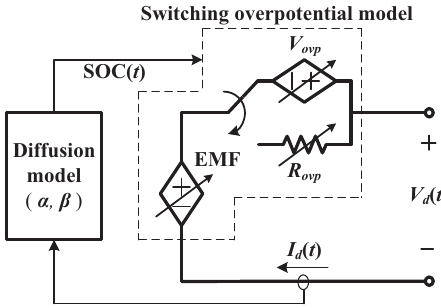
Figure 2. Hybrid battery model that combines a diffusion model and a switching overpotential